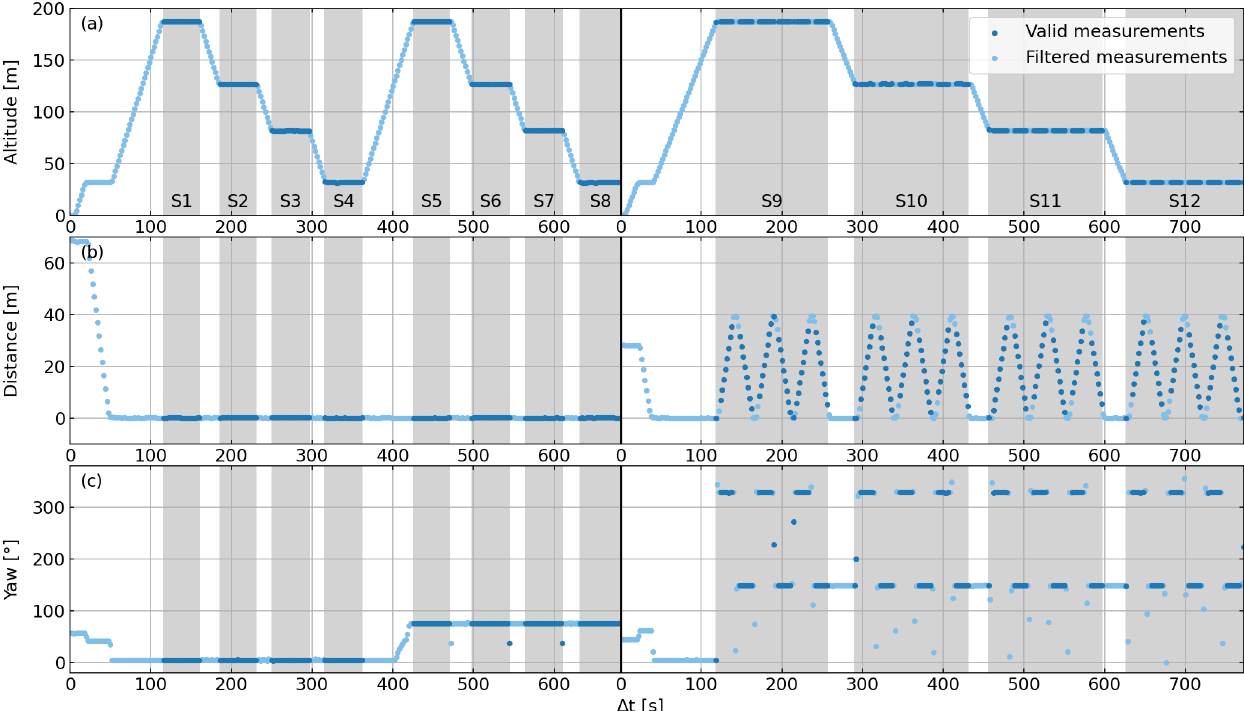
Figure A1. Detailed flight pattern of the validation flights at the ICOS atmospheric station Steinkimmen (STE), Germany, 9 April 2020. From top to bottom: altitude (a) , horizontal distance from the first valid measurement within each flight (b) , and yaw of the UAV (c) . Left: flight 1. Right: flight 2.